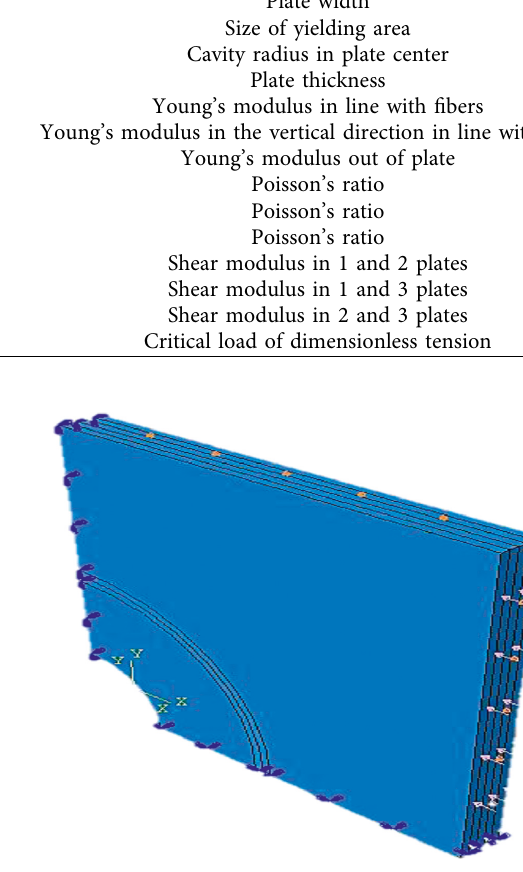
Figure 20: Plate under pressure